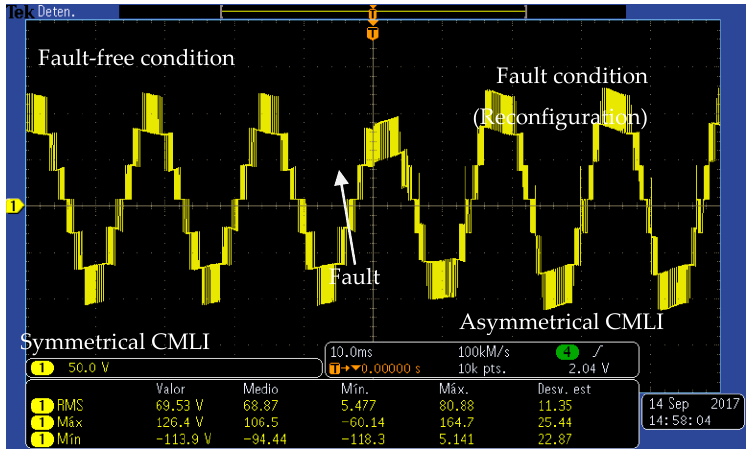
Figure 17. Oscillogram of the output voltage waveform behavior during the change from the fault-free condition to the fault condition (Reconfiguration).